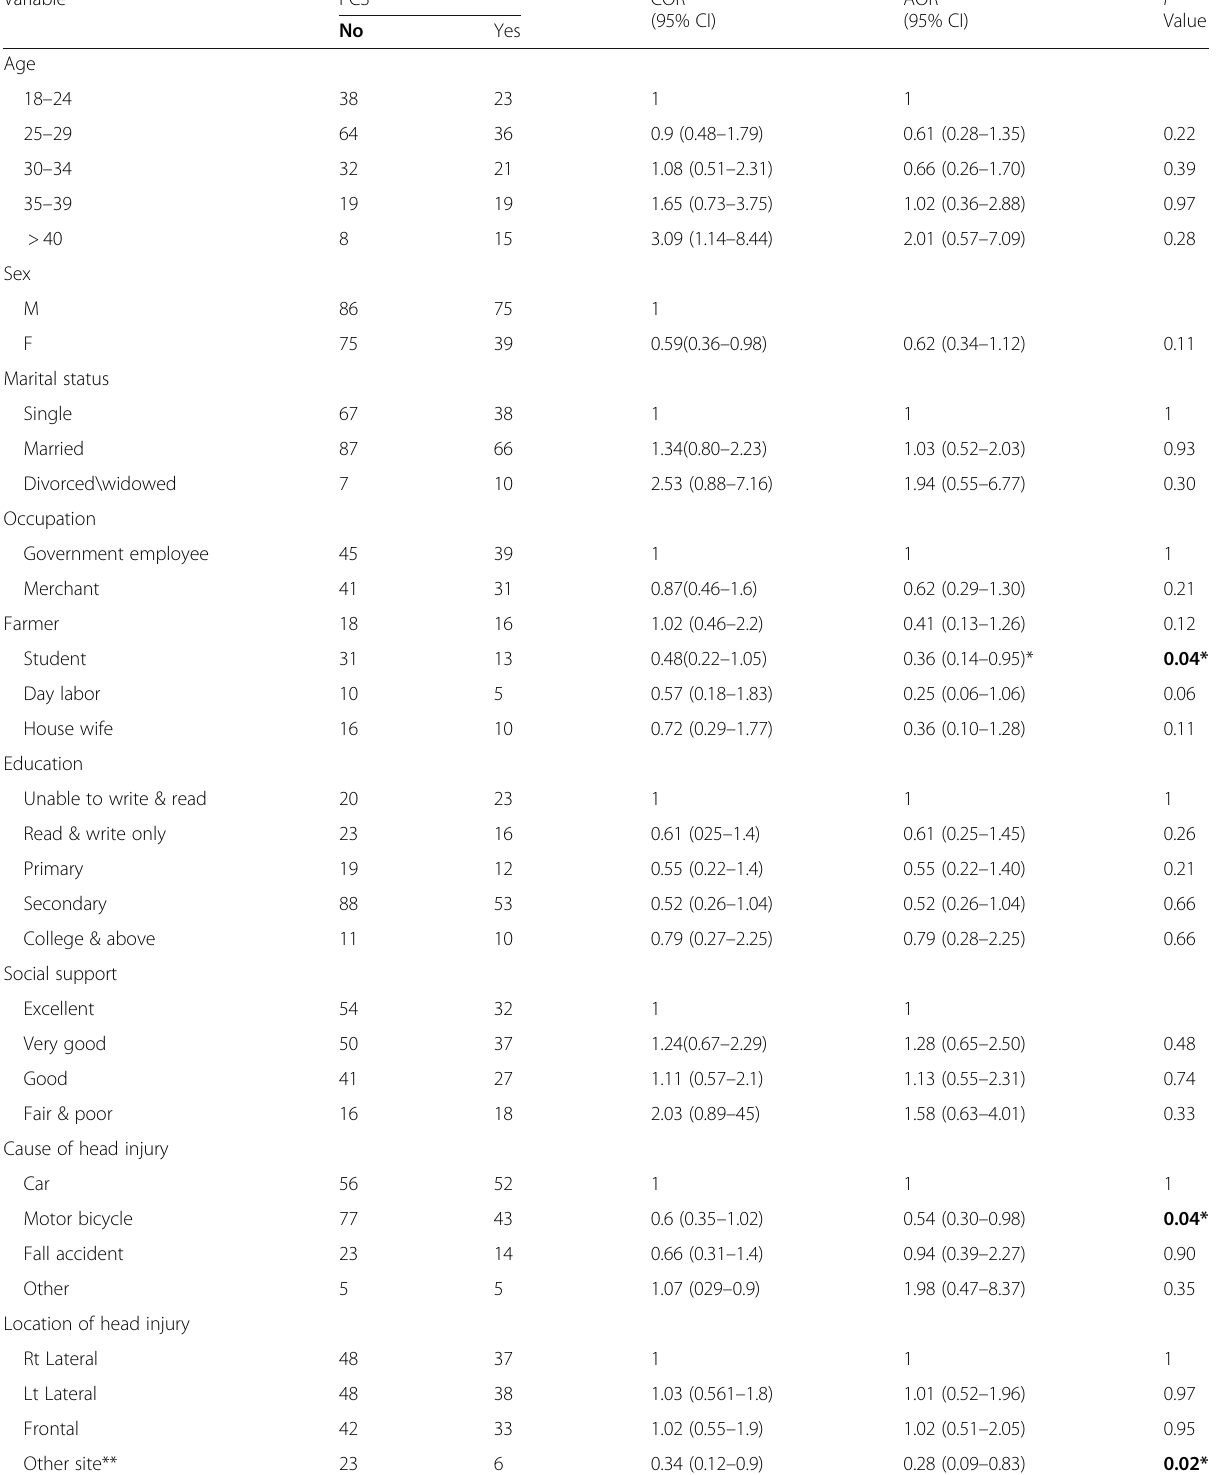
Table 3 Factors Associated PCS (Bivariate and Multivariate logistic regression) of study participants attending emergency outpatient department of Hawassa university compressive specialized hospital, Hawassa, Southern Ethiopia ( n =